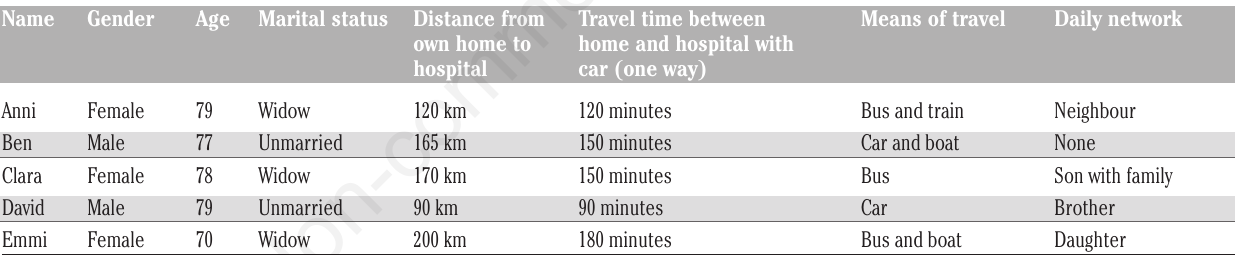
Table 1. Summary of participant background. Name